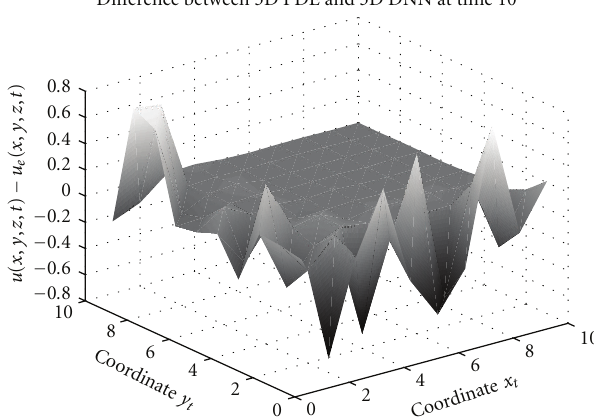
Figure 3: Numerical trajectory produced by the neural network de- scribed reproducing the model at time 10 s along the whole domain. Di ff erence between 3D PDE and 3D DNN at time 10